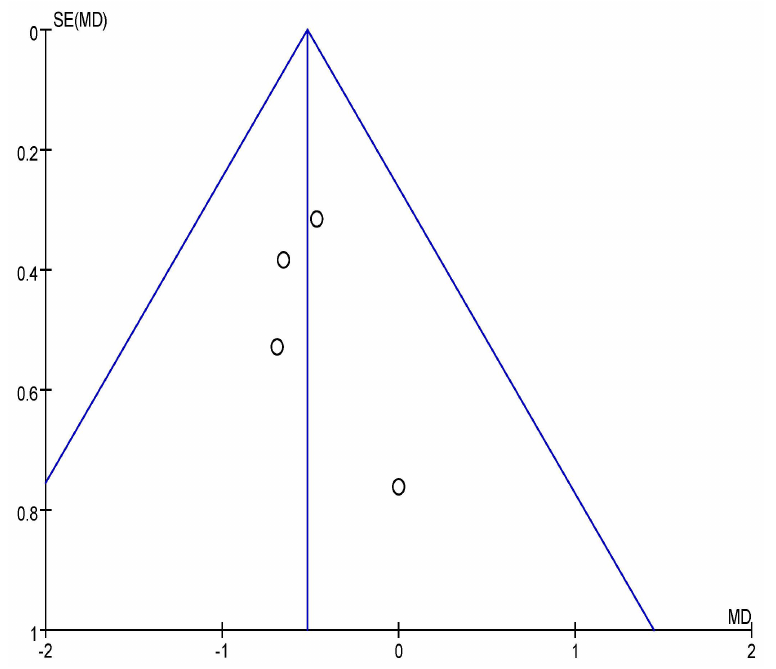
Figure 3. Funnel plot for the effect of OBG intake on fasting plasma glucose (FPG) concentration. For Ma 2013 [15], FPG concentration is obtained at a dose of 2.5 g/day